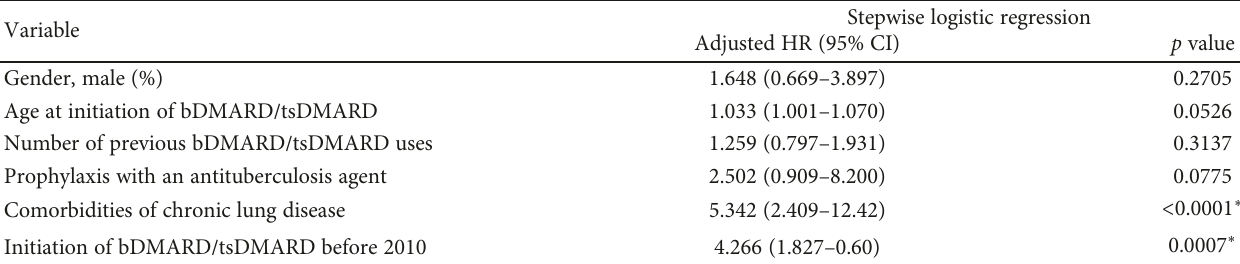
Table 3: The risk of infection in bDMARD uses analyzed with stepwise logistic regression.